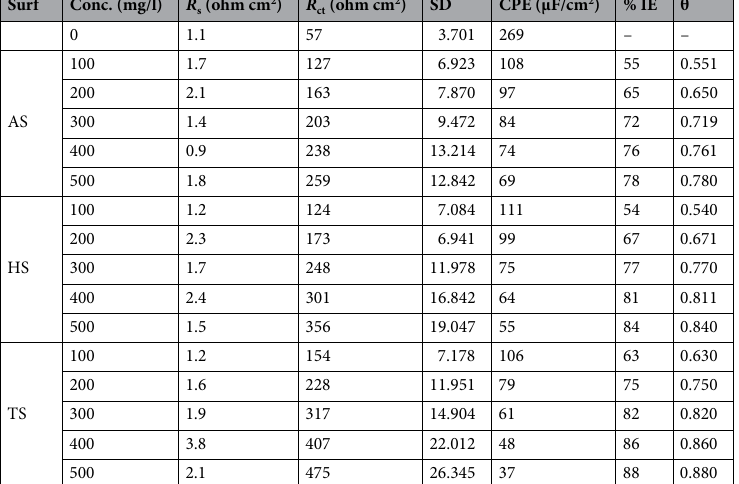
Table 4. Impedance parameters for the copper corrosion in 1.0 M H 2 SO 4 solution and in the presence of the examined surfactants at 298 K. AS sodium N-dodecyl asparagine, HS sodium N-dodecyl histidine, TS sodium N-dodecyl